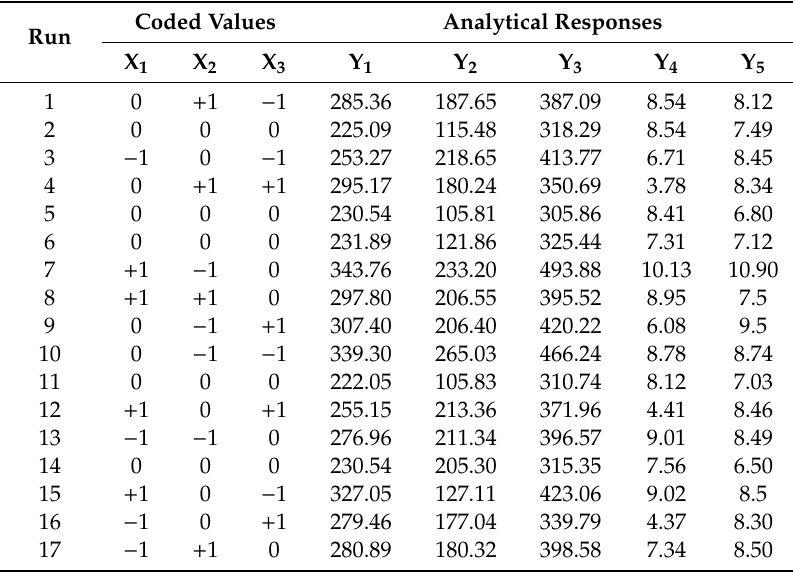
Table 3. Coded Box-Behnken design with the analytical responses. Coded Run